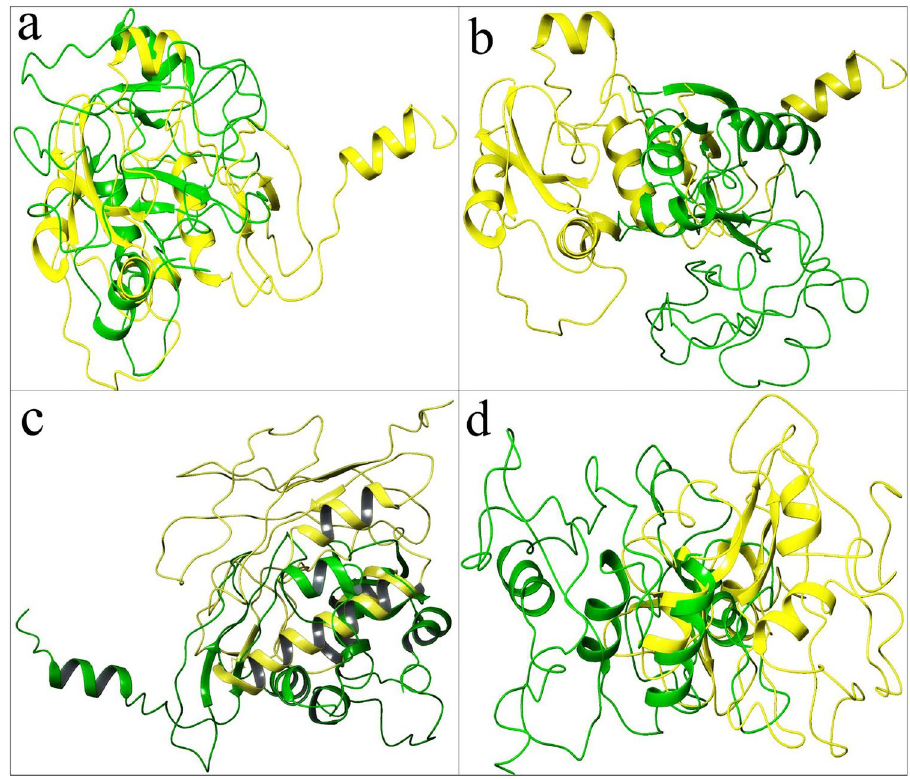
Figure 1. Structure alignment: ( a ) SPVC_214 (yellow) and SPVC_383 (green), 73.51% (SeqId), ( b ) SPVC_214 (yellow) and SPVC_387 (green), 39.13%, ( c ) REF_SEQ (yellow) and SPVC_214 (green), 17.3 Å , ( d ) SPVC_32 (yellow) and SPVC_446 (green) 3.38 Å